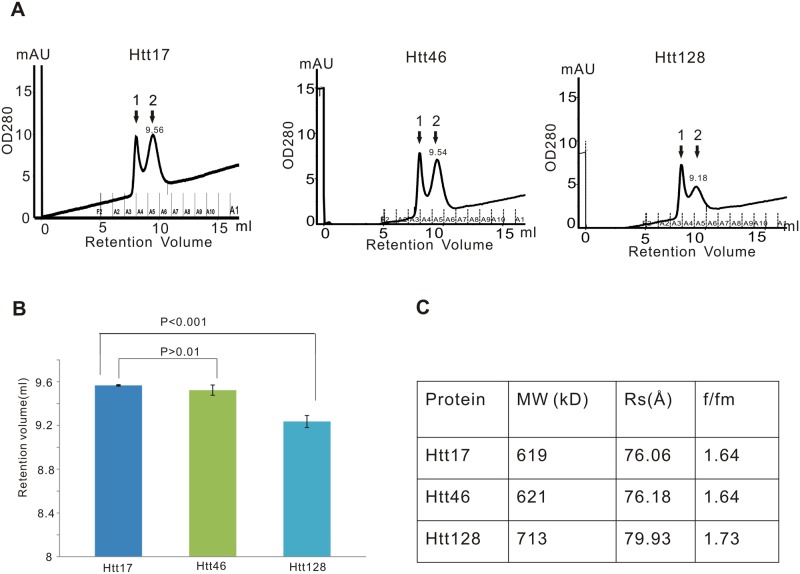
Analytical size exclusion chromatography.Htt is a molecule with elongated shape and mutant Htt128 is more extended than Htt17 and Htt46. (A) Htt17, Htt46 and Htt128 were analyzed by SEC with a Superdex-200 10/300 GL column to estimate the molecular weight (MW) and stoke radius (Rs). Htt oligomers eluted at peak 1 corresponding to the void volume of this column and Htt monomers eluted at peak 2. Htt17 and Htt46 eluted at retention volume of about 9.5 ml, while Htt128 eluted at a retention volume of about 9.18 ml. (B) There were no significant differences of the retention volumes between Htt16 and Htt46, while Htt128 eluted significantly earlier than Htt17 and Htt46. (C) From the SEC results and considering a calibration curve the MW of Htt would be calculated to have a MW of about 600 kD, which is significantly larger than its actual 350 kD MW, indicating that Htt is not a globular protein. The friction ratio f/fm represents the total shape asymmetry of molecules. The f/fm of 1.6 predicts that Htt has an elongated shape. The larger f/fm value of Htt128 than Htt17 and Htt46 indicated that the shape of Htt128 was more extended than the shapes of Htt17 and Htt46.